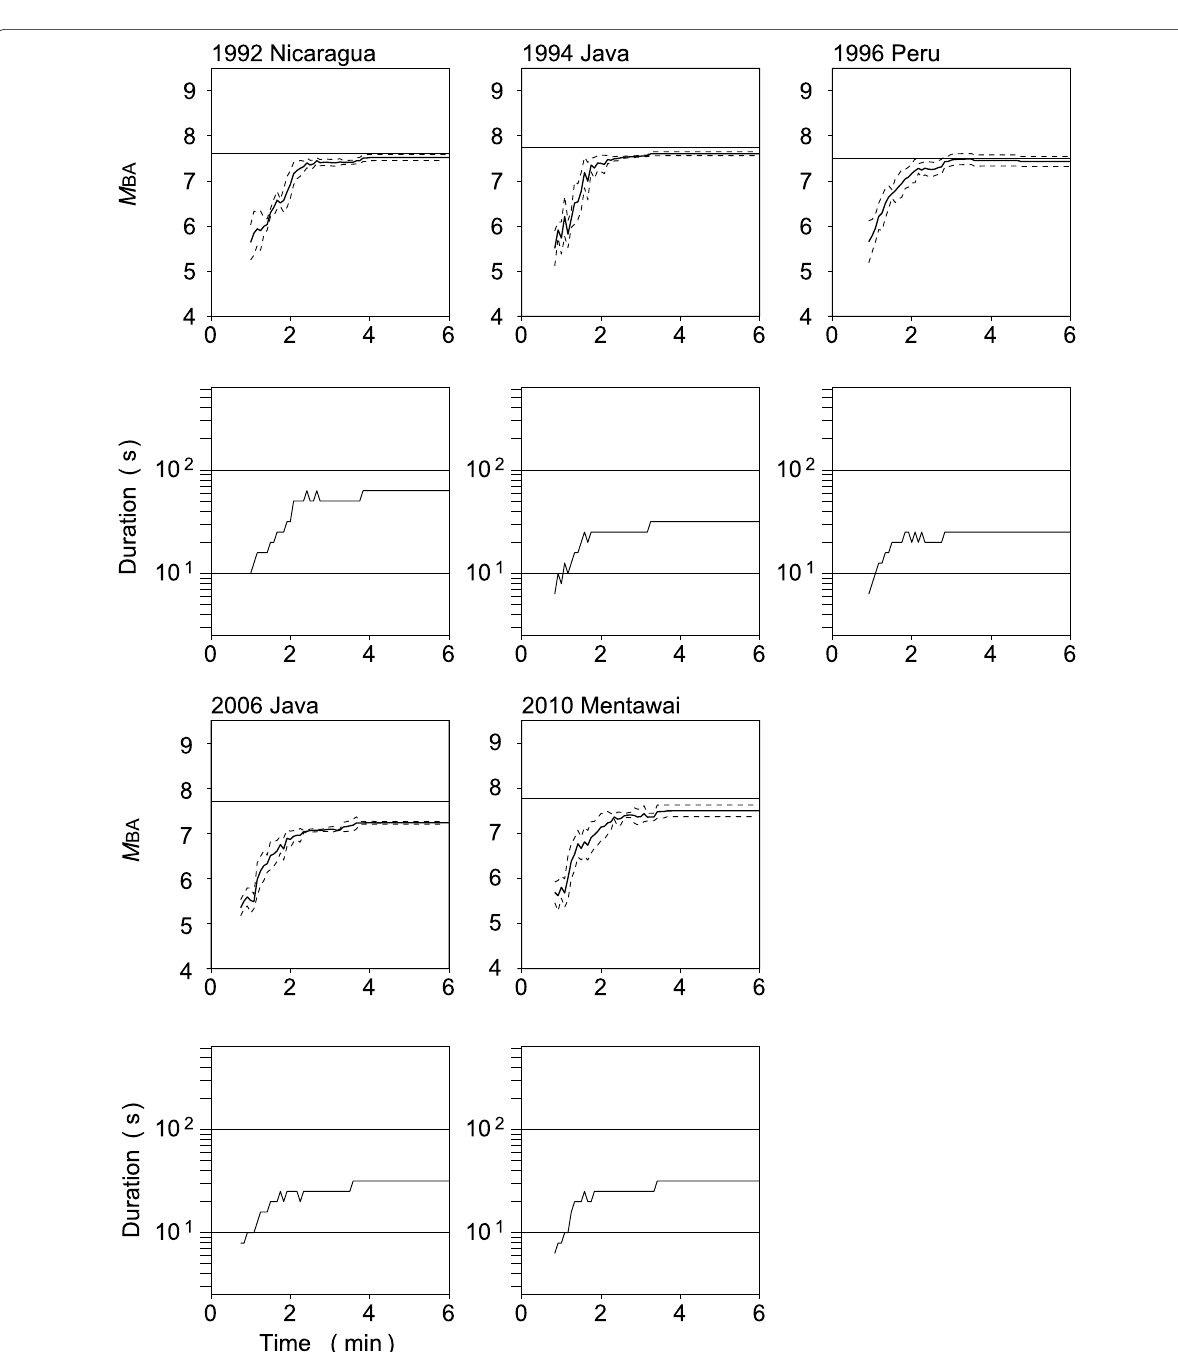
For the 1992 Nicaragua earthquake, we also com- pared the station number limit with the time required to approach the final M BA and M BA − M w .